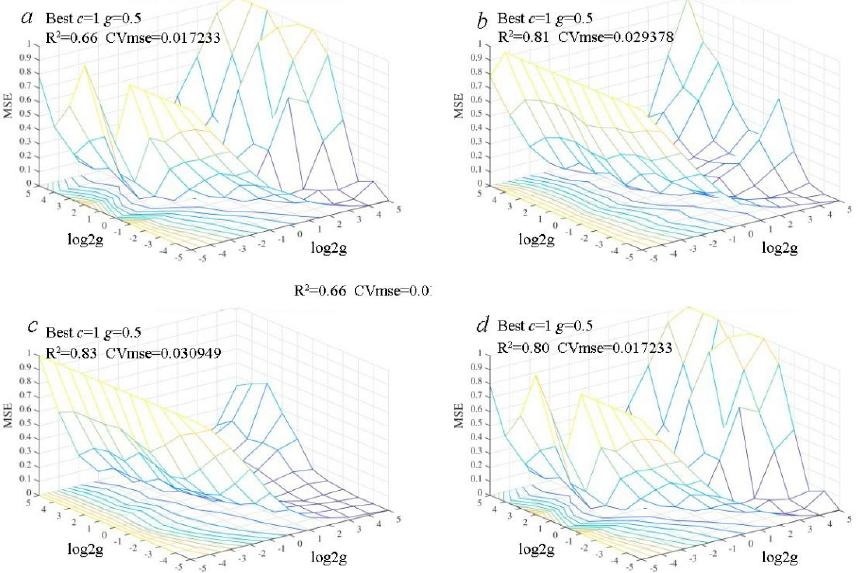
Figure 6. Optimal parameters of SVM model for clay ( a ), silt ( b ), sand ( c ), and mean grain-size ( d ).